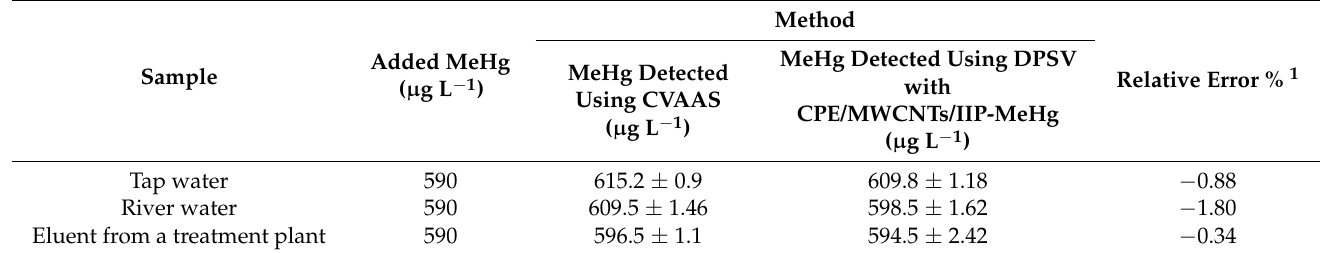
Table 2. Determination of methylmercury in water samples using the CPE/MWCNTs/IIP-MeHg sensor. For comparison purposes, MeHg concentration was also determined using the reference method: CVAAS (S/N =